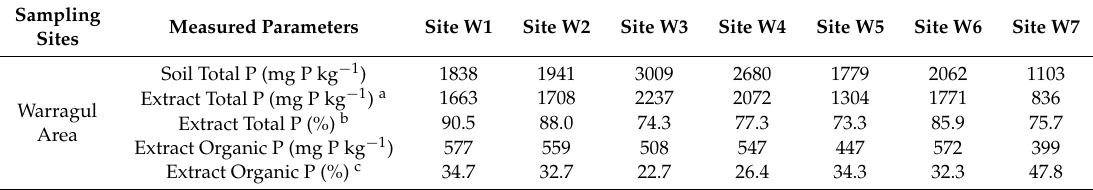
Table 3. Selected soil and soil extract (NaOH-EDTA) characteristics of individual sampling sites of the Warragul and Maffra